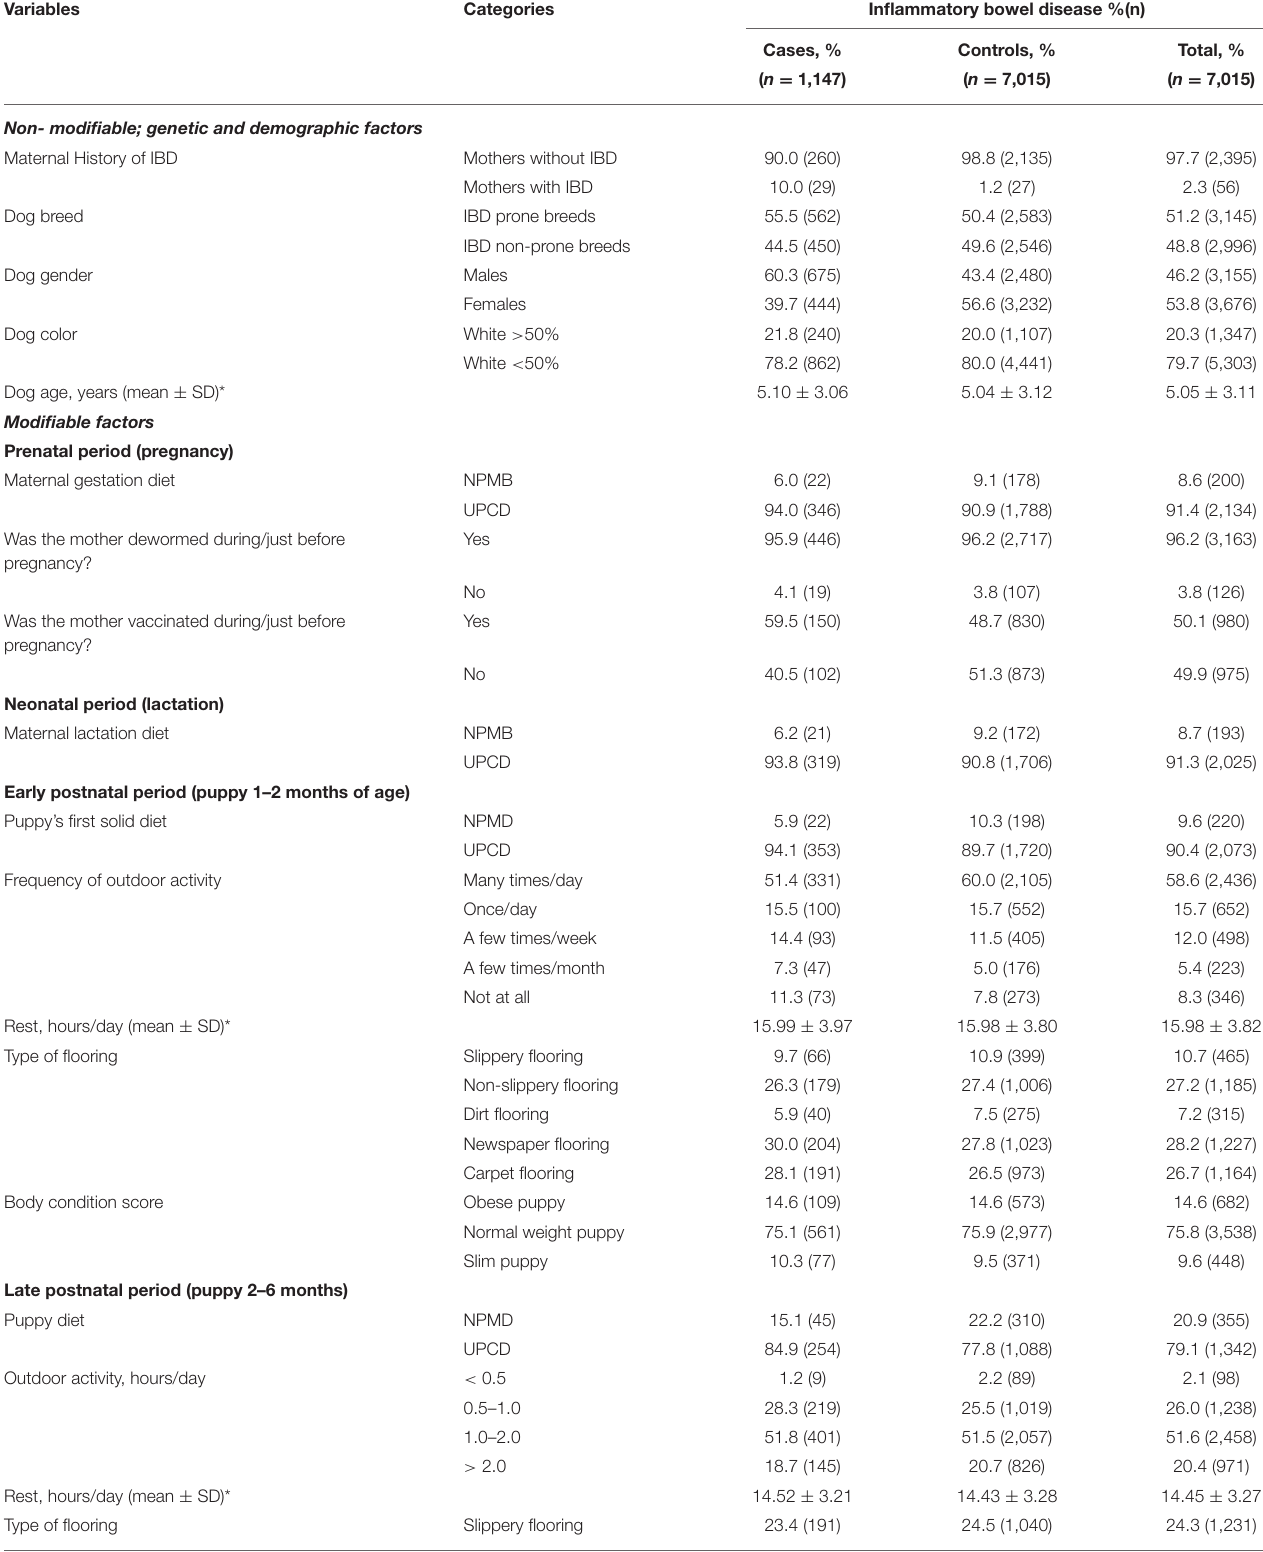
TABLE 2 | Frequencies of the tested variables in the cases, controls, and total study cohort.